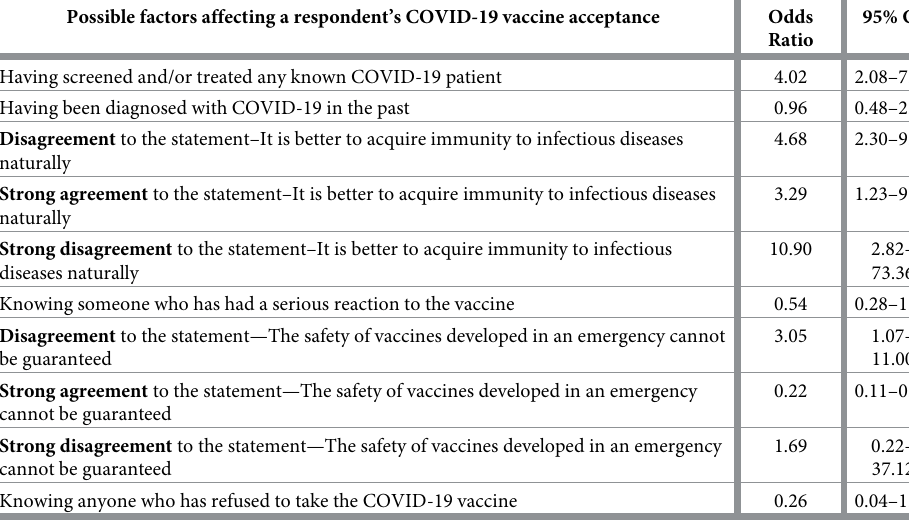
Table 4. Effects of non-demographic factors on vaccine acceptance of our survey respondents.